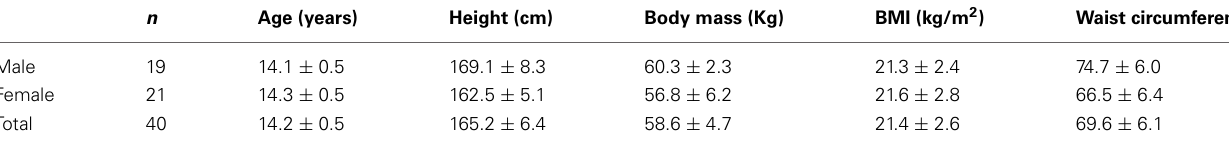
Table 1 | Anthropometric characteristics of